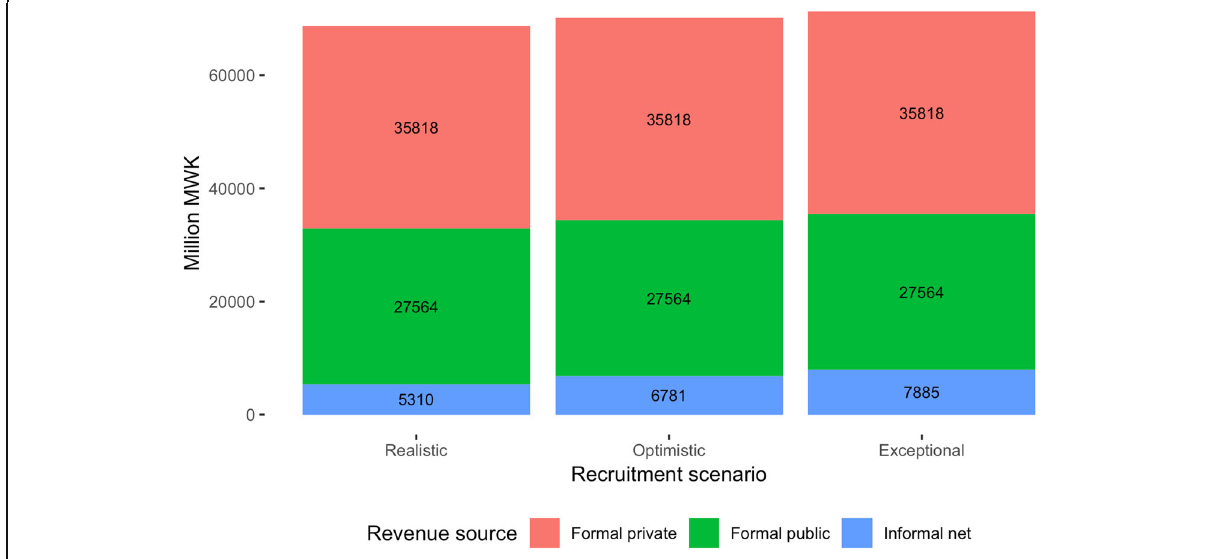
Fig. 1 Projected total net NHIS revenue, by expectation of NHIS enrolment